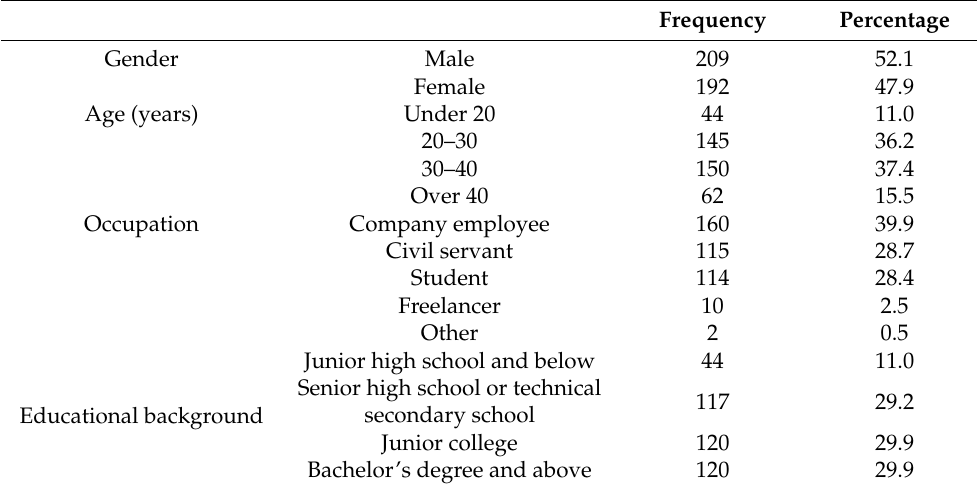
Table 1. Distribution of sample demographic